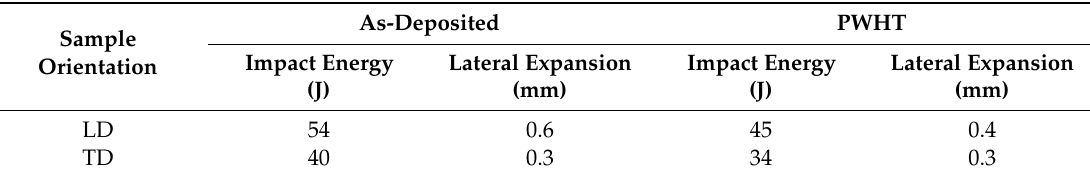
Table 6. Results of Charpy V-notch impact testing in longitudinal (LD) and transverse direction (TD) for as-deposited and PWHT condition.